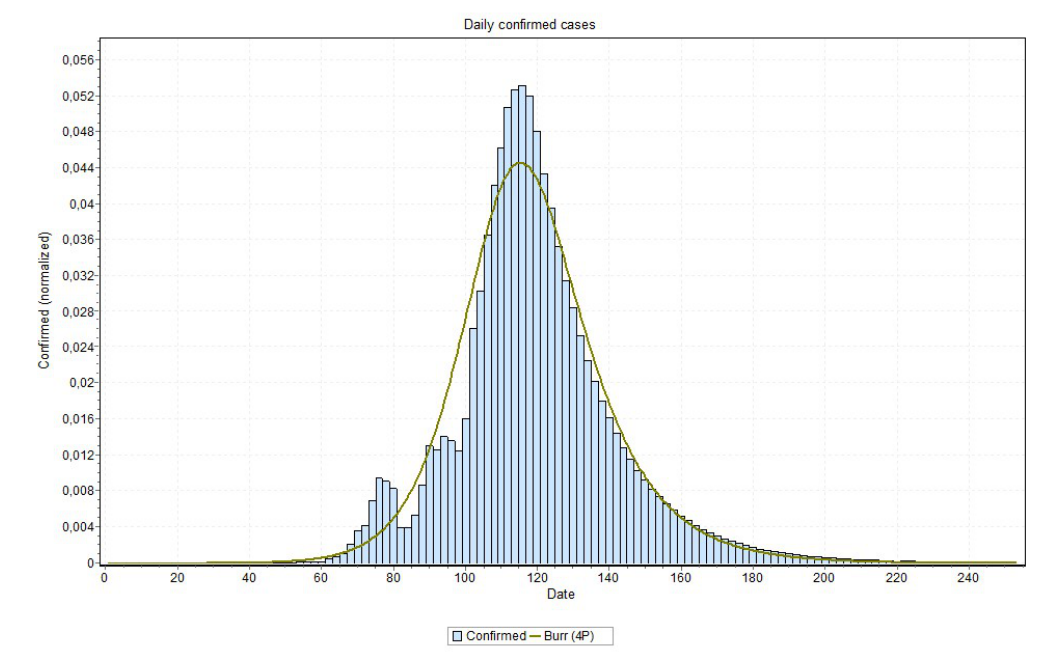
Figure 20. Curve fitting for Rio Grande do Norte state (Burr model was the best fit) with peak